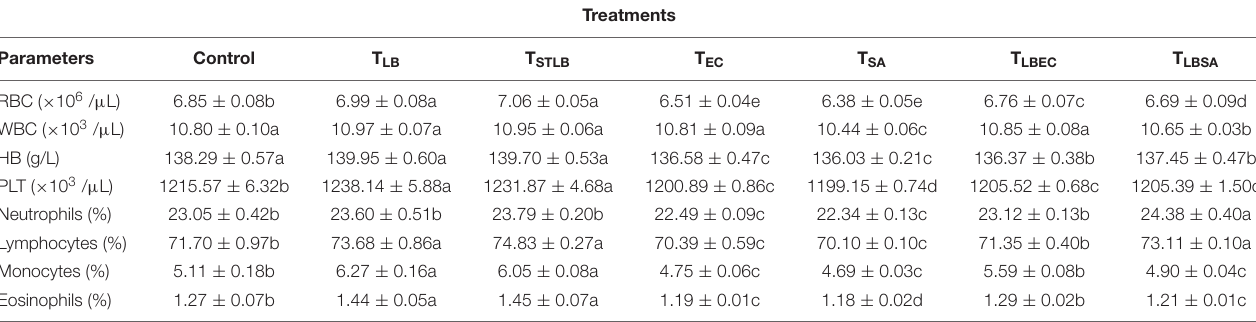
TABLE 4 | Hematological Parameters of Study animals after oral administration of L. bulgaricus KLDS 1.0207 for 14 days.